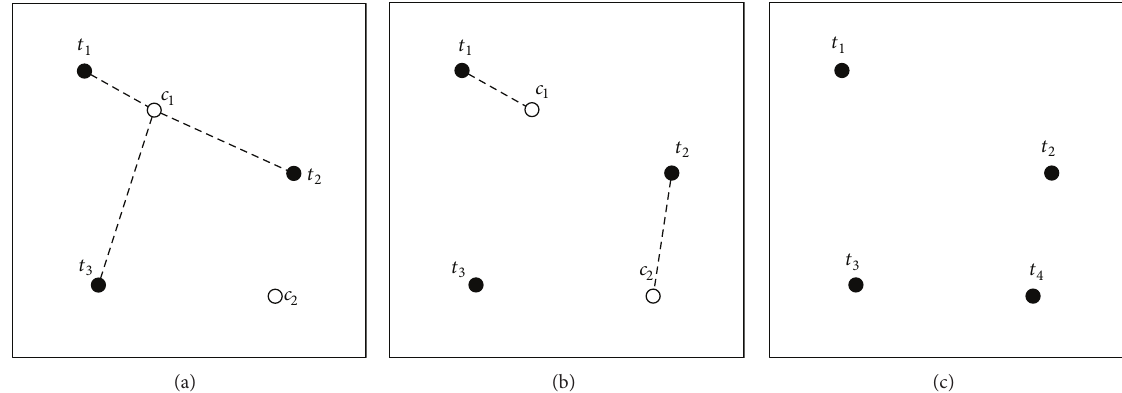
Figure 2: Illustration of FSCS-ART in a two-dimensional input domain. Previously executed test cases are denoted as 𝑡 1 , 𝑡 2 , and 𝑡 3 , and randomly generated candidates are denoted as 𝑐 1 and 𝑐 2 , respectively. To select the next test case, (a) multiple candidates are randomly selected, and the nearest previously executed test case to each candidate is determined; (b) these nearest distances are compared among all candidates; and (c) the candidate with the longest such distance is